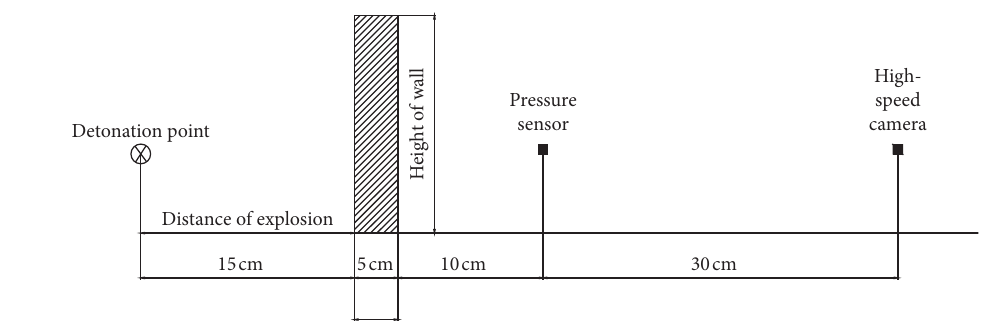
Figure 1: Layout of wave-resistance characteristics